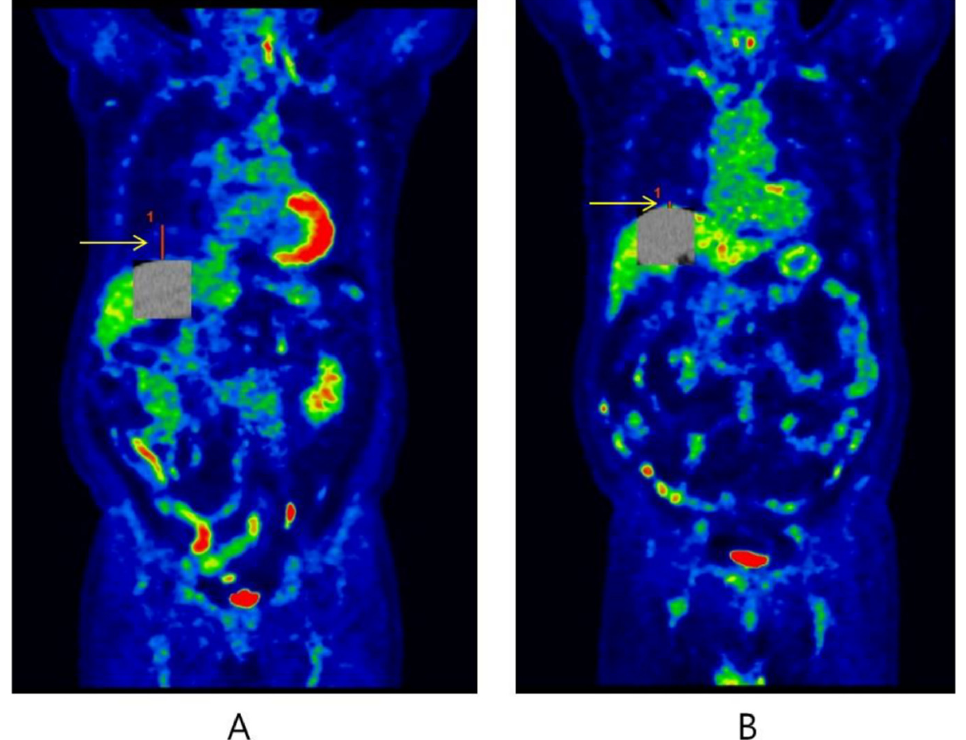
Figure 1. Coronal sections of 18 F-FDG PET/CT images indicating the length of misregistration (red line) using the Blend mode of the AW workstation (Volume Viewer version 14.0, GE Healthcare, USA). Case ( A ) was 68 years old male patient with lung cancer, who performed type (a) breathing protocol at 13 s CT scanning time. The length of PET/CT misregistration was 39.0 mm. Case ( B ) was 78 years old male patient with lung cancer, who performed type (c) breathing protocol at 8 s scanning time. The length of misregistration was 7.3 mm.